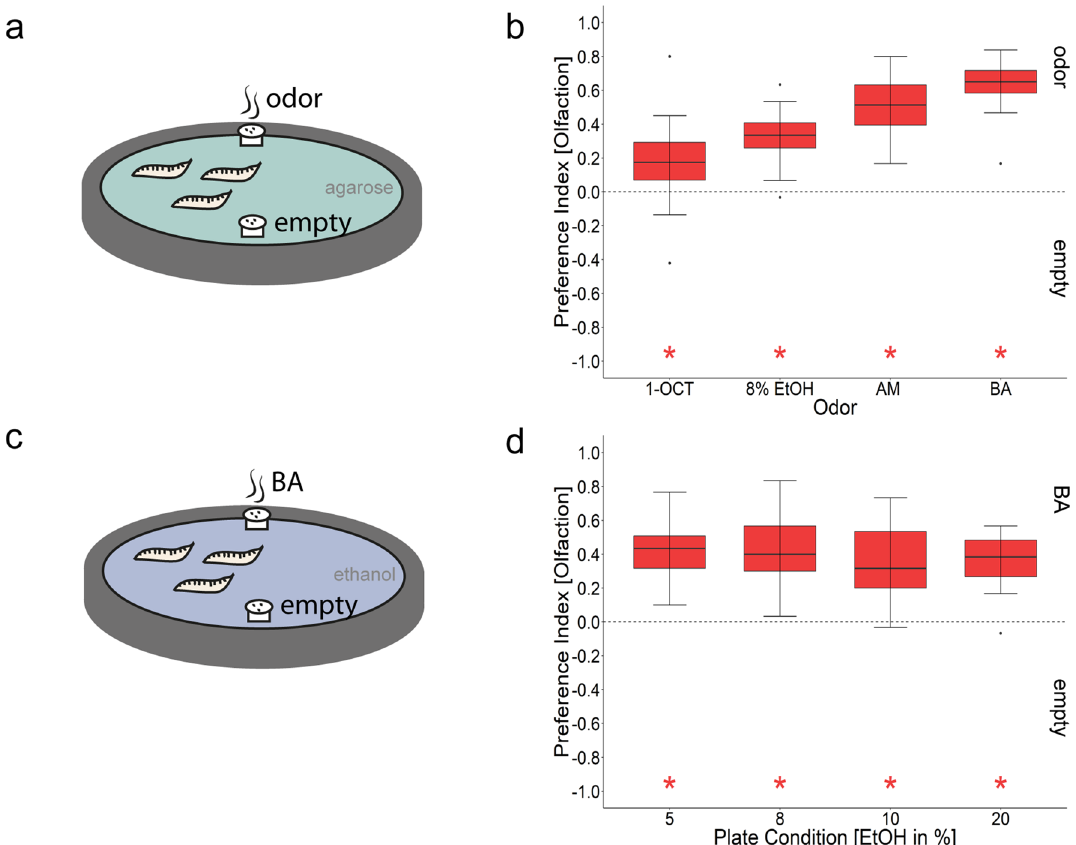
Figure 4. The effects of ethanol on larval olfactory attraction. ( a ) Scheme of the experimental procedure. The olfactory stimuli 1-OCT, AM, BA, and 8% ethanol were presented on a 2.5% agarose plate in custom made Teflon containers to prevent direct contact of the animals with the chemical. Larvae were allowed to crawl for 5 min. ( b ) Canton-S larvae preferred all odors including 8% ethanol over empty containers (n 1-Octanol = 19, Pref 1-Octanol = 0.17, ci = 0.04–0.29, n AM = 8, Pref AM = 0.51, ci = 0.3–0.69, n 8%Ethanol = 16, Pref 8%Ethanol = 0.33, ci = 0.24– 0.41, n BA = 16, Pref BA = 0.65, ci = 0.55–0.72). All groups were significantly different to zero (one-sample t test, p 1-octanol < 0.011, p AM < 0.001, p 8%Ethanol < 0.001, p BA < 0.001). ( c ) Scheme of the experimental procedure. Test plates contained 2.5% agarose mixed with either 5%, 8%, 10%, or 20% ethanol. BA was presented in Teflon containers. Larvae were allowed to crawl for 5 min. ( d ) Canton-S larvae showed an olfactory preference for BA irrespective of the ethanol concentrations in the test plate. All groups were significantly different to zero (one-sample t test, p BA-5%Ethanol < 0.001, p BA-8%Ethanol < 0.001, p BA-10%Ethanol < 0.001, p BA-20%Ethanol < 0.001), but not different from each other (ANOVA, p < 0.697). Sample size for each box plot is n = 16. Differences against zero are indicated in red at the bottom of each panel. Significant differences of two groups are specifically indicated with an asterisk.